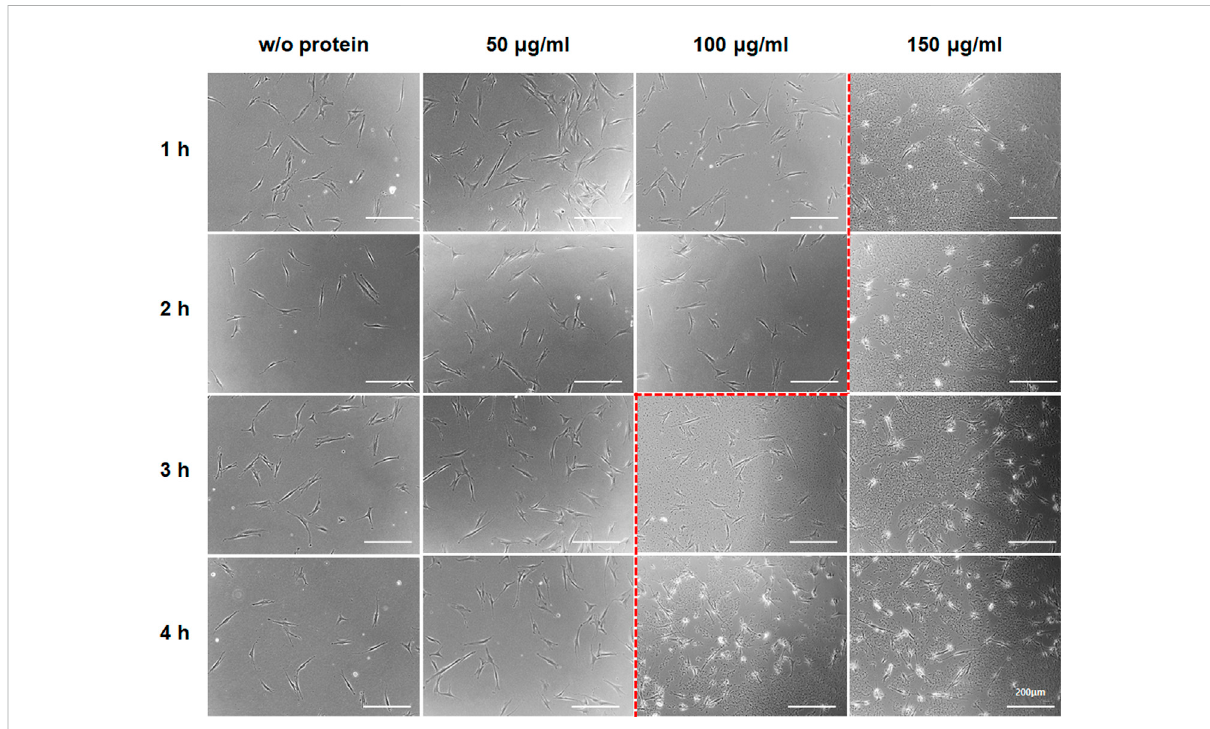
Aggregate-like forms of the Lin28-30Kc19 protein. HDFs treated with the Lin28-30Kc19 protein were observed through a microscope, depending upon the concentration of the protein and incubation time with the protein. Based on the red dotted line, the right region showed an aggregation tendency of the protein. Scale bars indicate 200 μ